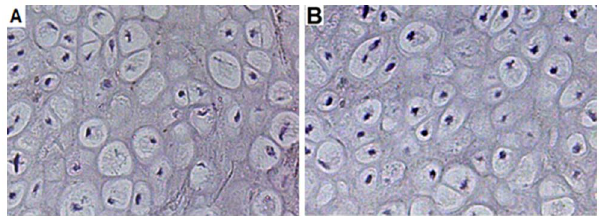
Figure 3. Immunohistochemistry of cell proliferation as indicated by proliferating cell nuclear antigen (PCNA) expres- sion within the callus of a control animal (A) and a telmisartan- treated animal (B) at 2 weeks post-fracture.